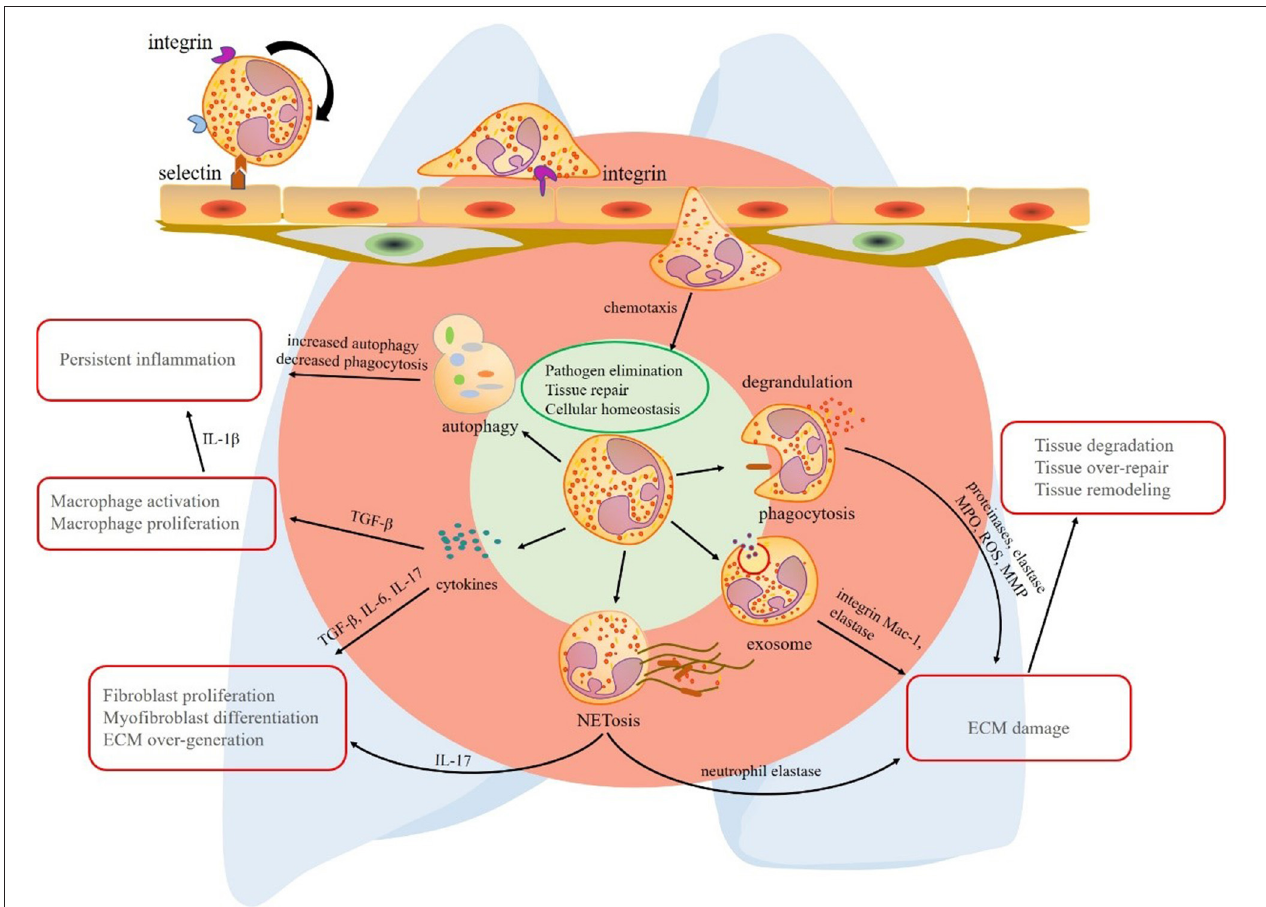
FIGURE 1 | The multiple effects of neutrophils in lung fibrosis. Circulating neutrophils roll, adhere, crawl, and transmigrate to chemokines to lung tissue. In the lung tissue, neutrophils play their roles via phagocytosis, degranulation, neutrophil extracellular trap (NET) formation, exosome secretion, release of cytokines, and autophagy redox balance. The primary common features of these mechanisms are pathogen elimination, tissue repair, and cellular homeostasis, respectively. However, the mechanisms that promote the progression of chronic inflammatory lung disease are quite different. Phagocytosis, degrandulation, NET formation, and exosomes contribute to ECM injury and tissue damage-repair-remodeling. In addition to ECM damage, NETs play a role in activating immune responses and release pro-fibrotic factor IL-17. Although neutrophil autophagy effect is limited, increased proportion of autophagy in neutrophil deduces the ability of eliminating inflammation. A vast of pro-fibrotic cytokines released by neutrophils contribute to lung fibrosis formation, respectively. Transforming growth factor (TGF)- β promotes persistent inflammation by macrophage activation and proliferation. interleukin (IL)-17 derived from neutrophils or NETs induces fibroblast proliferation and myofibroblast differentiation. As a result, extracellular matrix (ECM) is over-expressed in interstitial tissue of lung. TGF- β , transforming growth factor- β ; IL-17, interleukin-17; NET, neutrophil extracellular trap; ECM, extracellular matrix; MPO, myeloperoxidase; ROS, reactive oxygen species; MMP, matrix